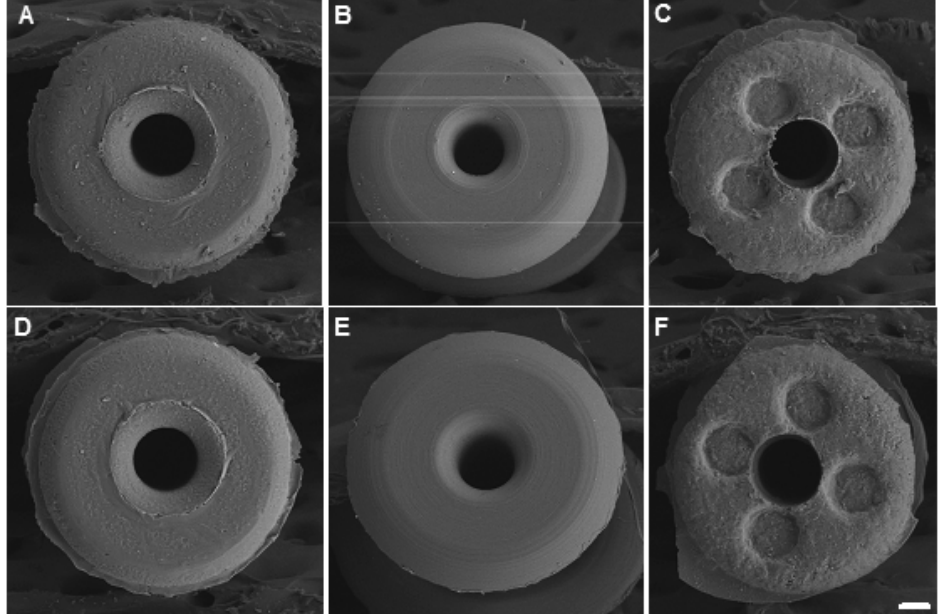
Figure 3. Image analyses of occluders. The top surface of the three types of unused (control) and with seven days in the presence of S. aureus (experimental) occluders were imaged using scanning electron microscopy(SEM).( A )ControlDelta R ; ( B )ControlOdyssey R ; ( C )ControlAlphamed R ; ( D )Experimental Delta R ; ( E ) Experimental Odyssey R and ( F ) Experimental Alphamed R . Scale bar = 100 µm.